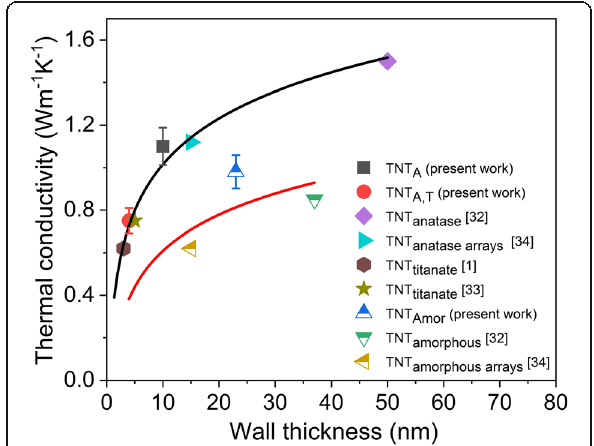
Fig. 5 The thermal conductivity of crystalline and amorphous titania nanotubes with respect to their wall thickness. The trend lines are added for a visual